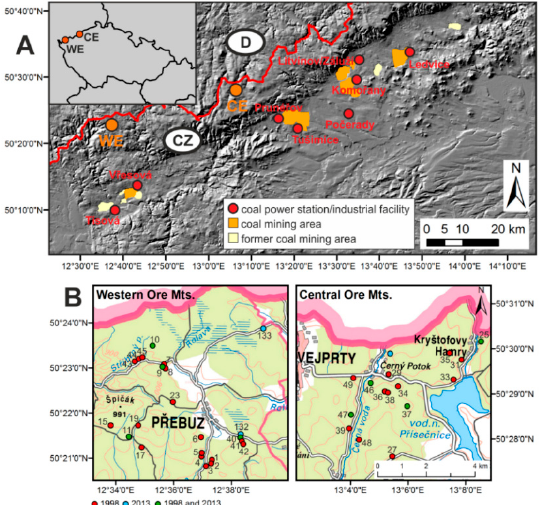
Figure 1. ( A ) Main sources of air pollution (coal power stations, heavy industrial facilities, etc. ) in the Ore Mountains region; ( B ) Detailed maps of the western (WE) and central (CE) Ore Mountains sites with positions of the Norway spruce stands sampled during the field campaigns in 1998 and 2013. Background map provided by Č UZK.